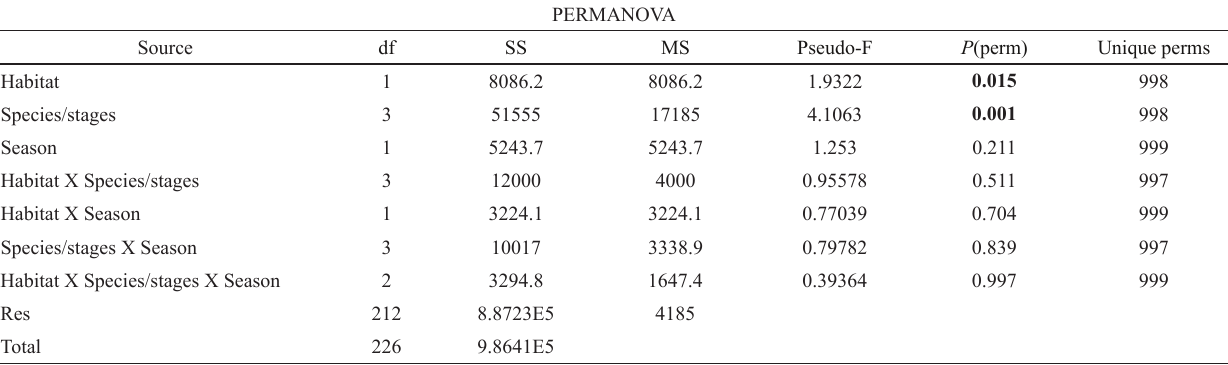
Tab. 2. Results from two-way crossed PERMANOVA of red and black grouper diet data. df = Degree of freedom, SS = sum of squares, MS = mean squares.